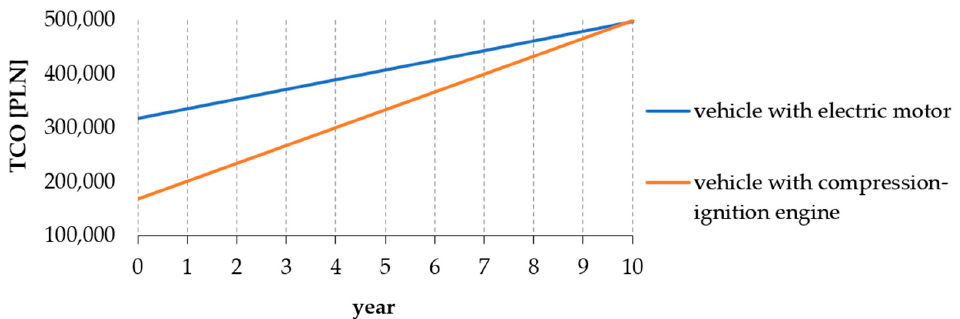
Figure 17. Total cost of ownership of vehicle during the whole operating period—electric vehicle is recharged only at public AC charging stations (the lowest price for 1 kWh was included in the calculations—Scenario A2).